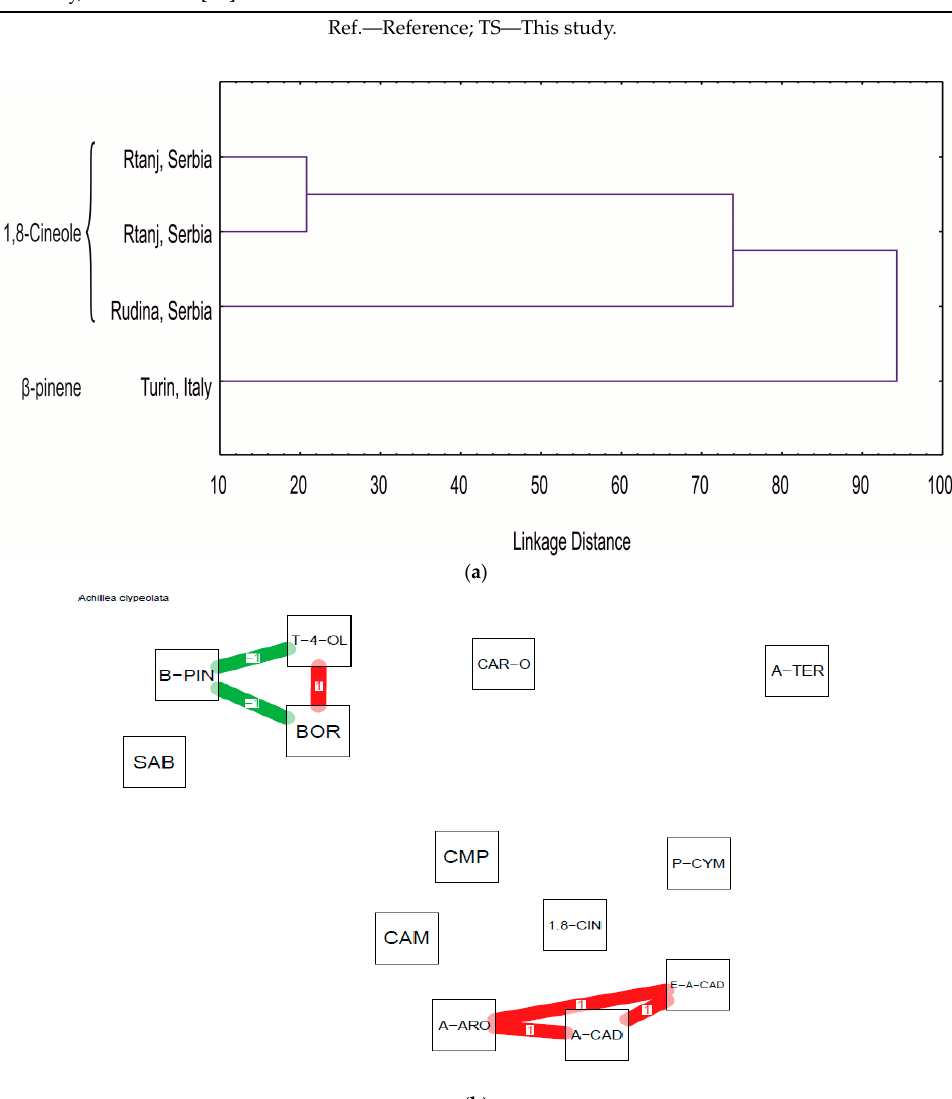
Figure 5. ( a ) Dendogram of the EO constituents of A. clypeolata from this study and from literature reports (the samples are marked according to Table 7); ( b ) correlation network based on A. clypeolata